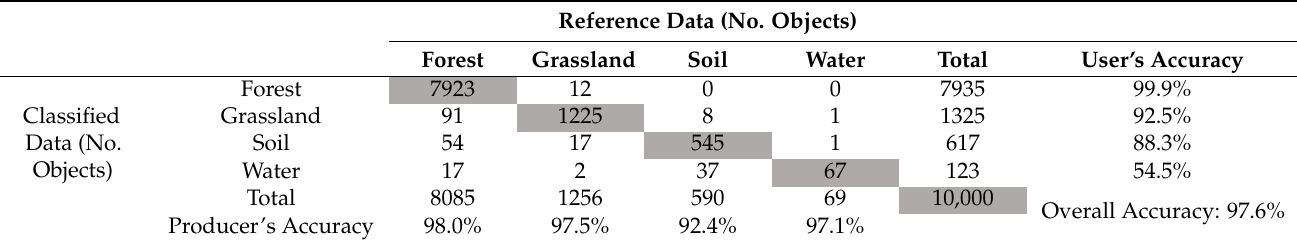
Table 9. Confusion matrix for the SVM classification trained from 10,000 samples graphed in Figure 5. Reference Data (No.